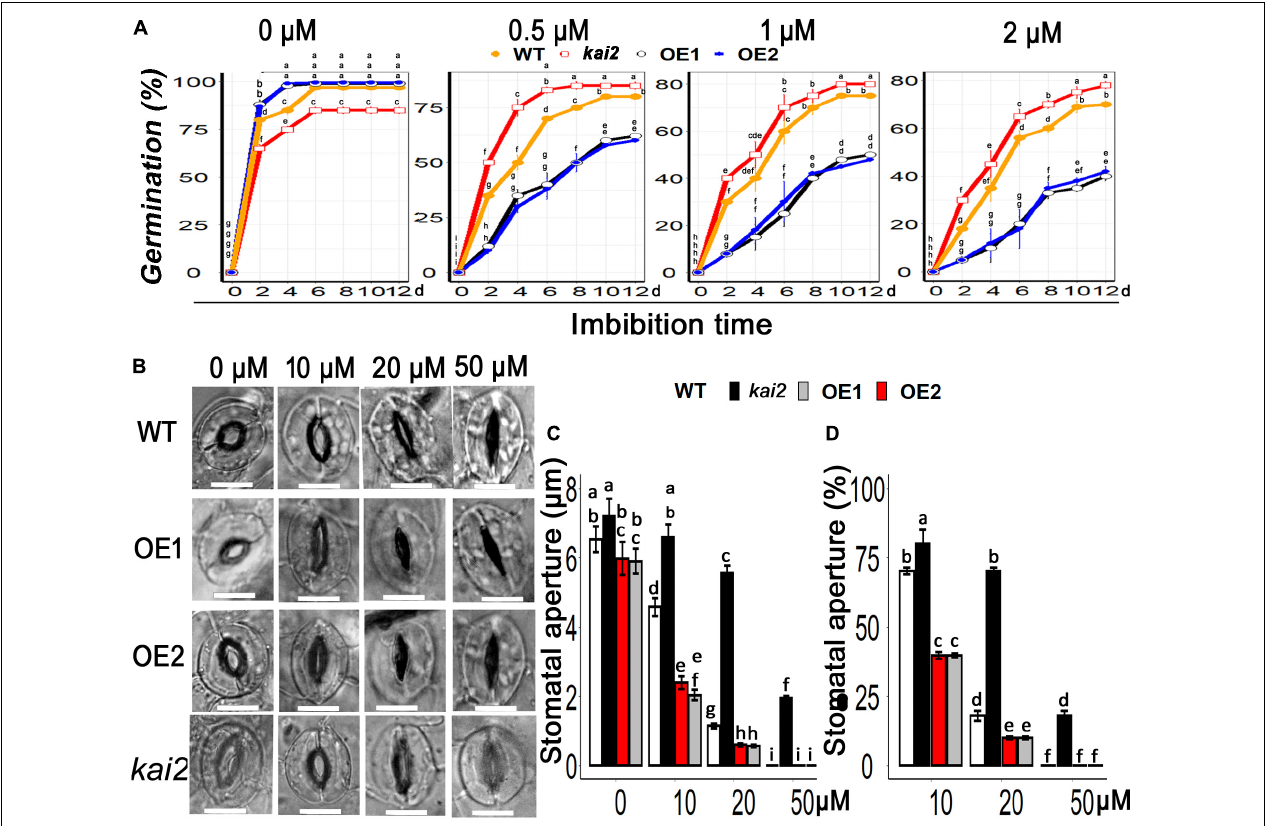
FIGURE 7 | SsKAI2 OEs were hypersensitive to exogenous ABA. (A) An effect of ABA on seed germination in KAI2 overexpression line1 (OE1), line2 (OE2), WT (Col-0), and Atkai2 Arabidopsis . (B) KAI2 plants stomata showed hypersensitivity to ABA. 25-day-old plant leaves were selected for this treatment; white bar = 50 µ M. (C) Stomatal aperture under different concentrations of ABA. (D) Stomatal aperture percentage closed after ABA treatment. Data shown are the mean ± SD of 15 replicates. One-way ANOVA was used to analyzed all data, and HSD Tukey’s test was used to perform multiple comparisons at P < 0.05 significant level ( n = 15). Bars or points with uncommon letters showing significant difference at P <